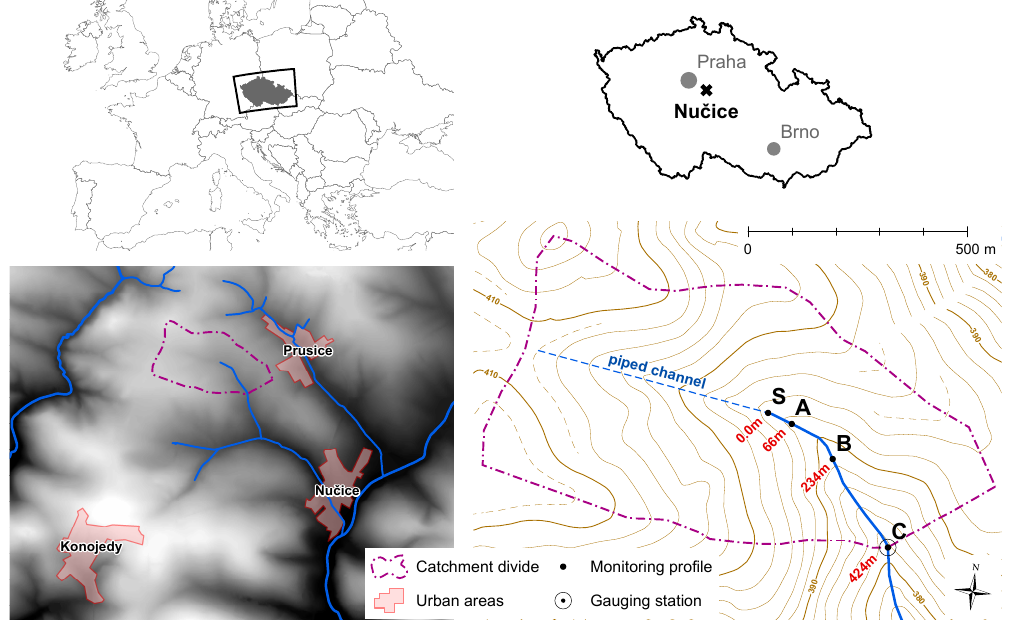
Figure 1. Map of the Nuˇcice catchment with the measurement